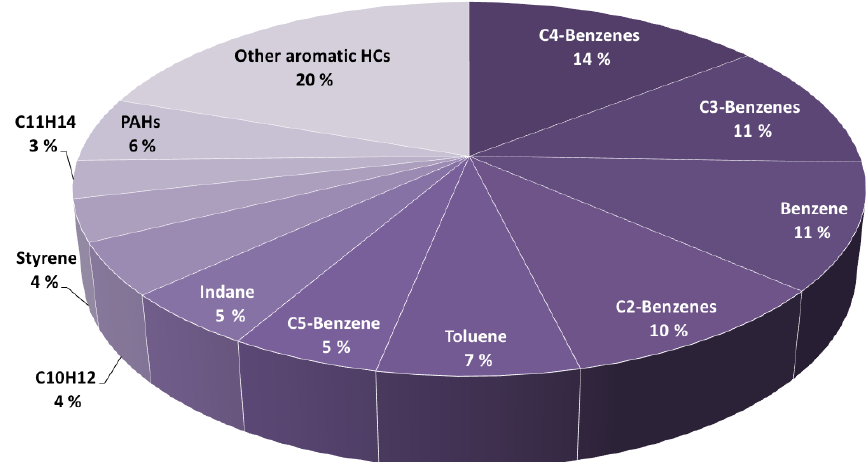
Figure 4. Mass fractions of aromatic compounds for primary emissions (directly emitted) at idle (thrust 3–7%). Benzene derivatives, xylenes, tri-, tetra-, pentamethylbenzene, benzene and toluene account for ∼ 60% of all aromatics.